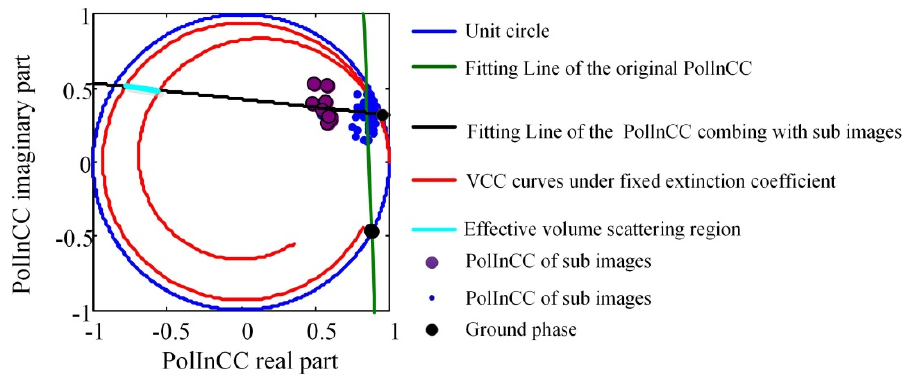
Figure 9. Estimation process of forest height in a pixel unit using real X-band PolInSAR data.